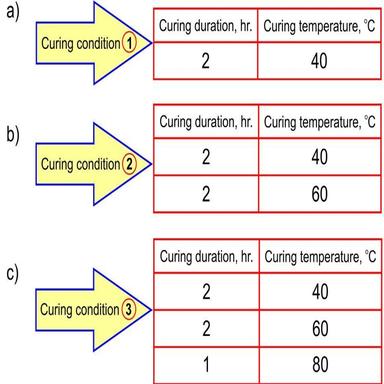
Curing duration and temperature of different conditions.